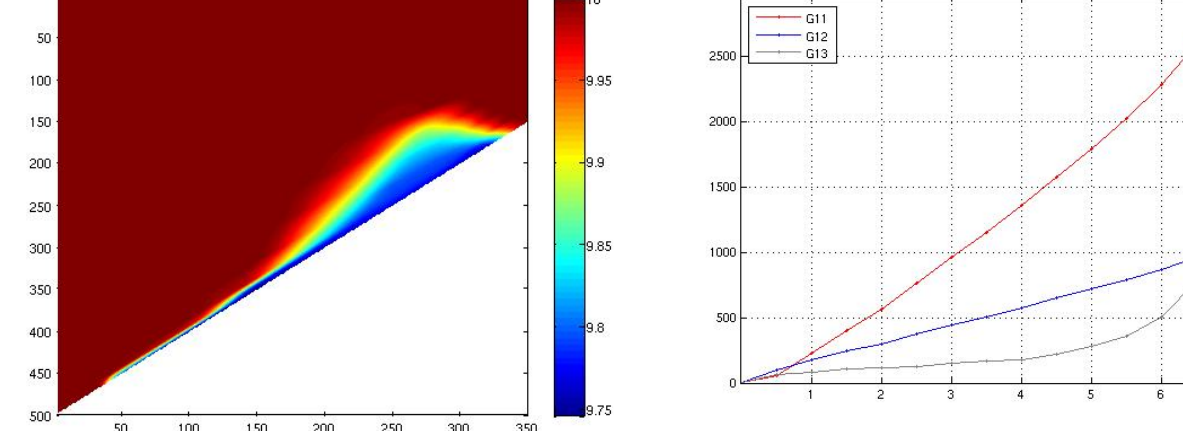
Fig. 8. Down-slope displacement of the centre of gravity of the gravity current in the 3-D experiments during the first 7 days of the experiments. Vertical axis in metres and horizontal axis in days.